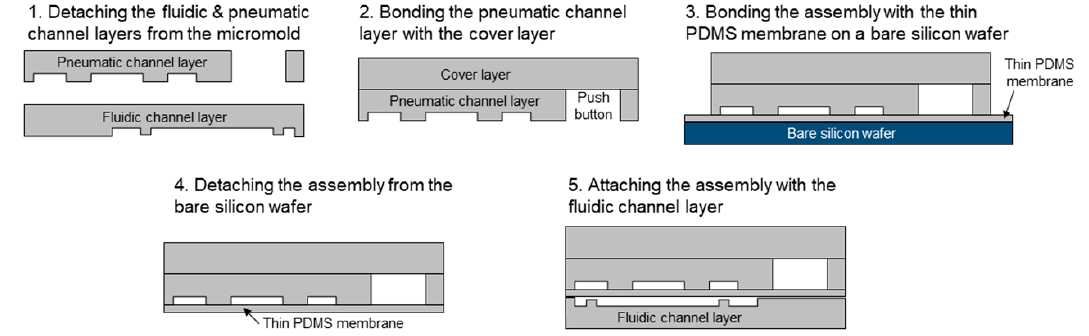
Figure 2. Fabrication processes of a finger-actuated microfluidic device.